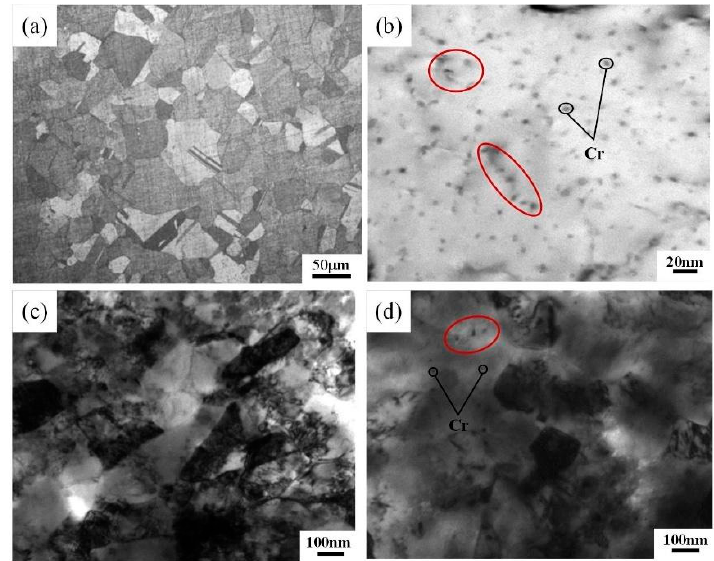
Figure 2. ( a ) Optical microscopy (OM) of the CG sample with solution at 980 °C for 40 min; ( b )